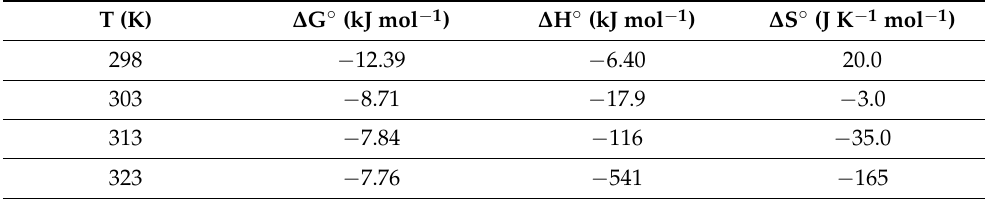
Table 3. Thermodynamic parameters for MB extraction from aqueous solutions using